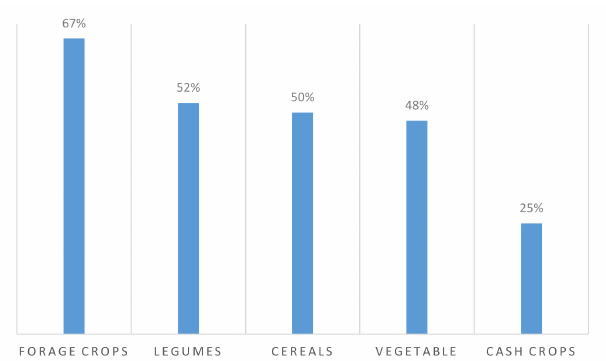
Figure 2. Percentage reduction in the number of landraces cultivated in the study area before and after 2019 by crop category.